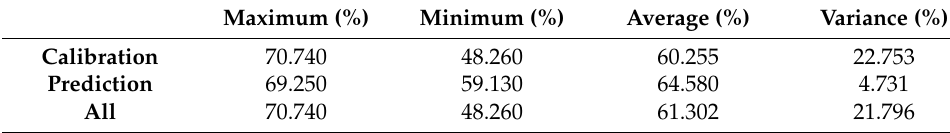
Table 1. Results of the moisture content analysis of Pinus massoniana seedling leaves. Maximum (%)